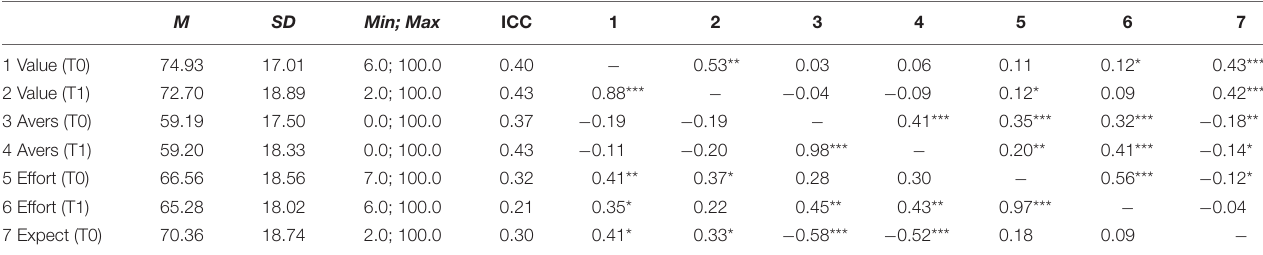
FIGURE 1 | Data flow indicating the subset of Level 1 observations available for the analyses conducted to answer the research questions under investigation. In total, n = 501 Level 1 observations fulfilled the eligibility criteria (shadowed boxes): participants (Level 2; N = 75) planned a task (T0 measurements); indicated that the task was study-related, and completed the intention-realization assessments (T1 measurements) for these tasks. TABLE 1 | Descriptive statistics (grand mean, SD, range), ICC and level-specific bivariate correlations for the unstandardized task-specific appraisals (Level 1; n = 501 study-related tasks) indicated by the participants (Level 2; N = 75) during planning (T0) and intention realization assessments